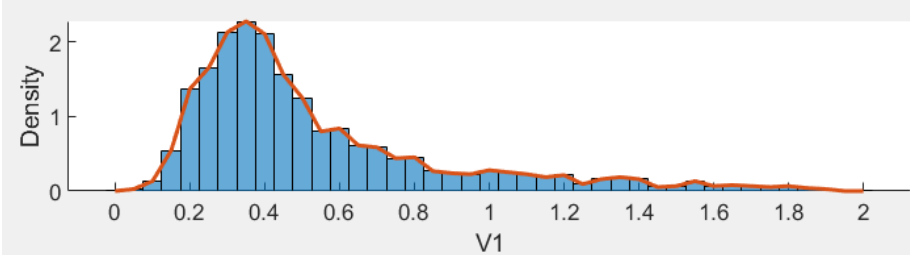
Figure 7. Histogram of the probability density function of V1(t).